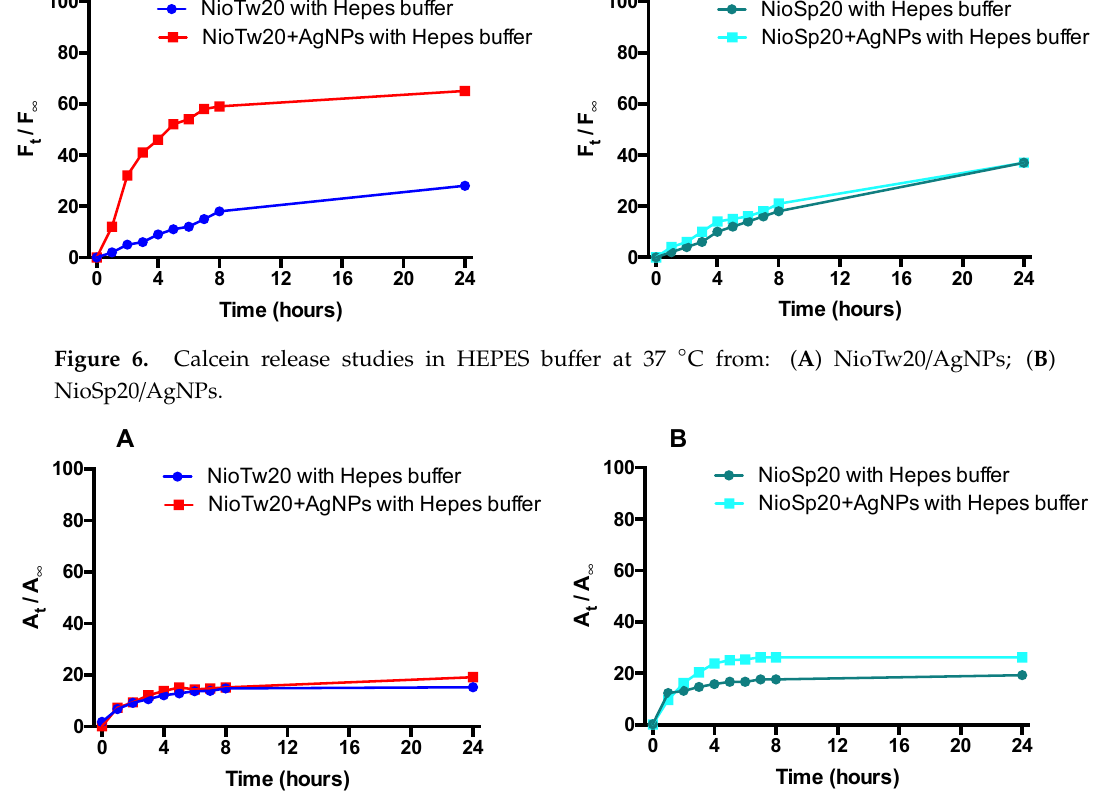
Figure 7. Nile Red release studies in HEPES buffer at 37 °C ( A ) NioTw20/AgNPs; ( B ) NioSp20/AgNPs.